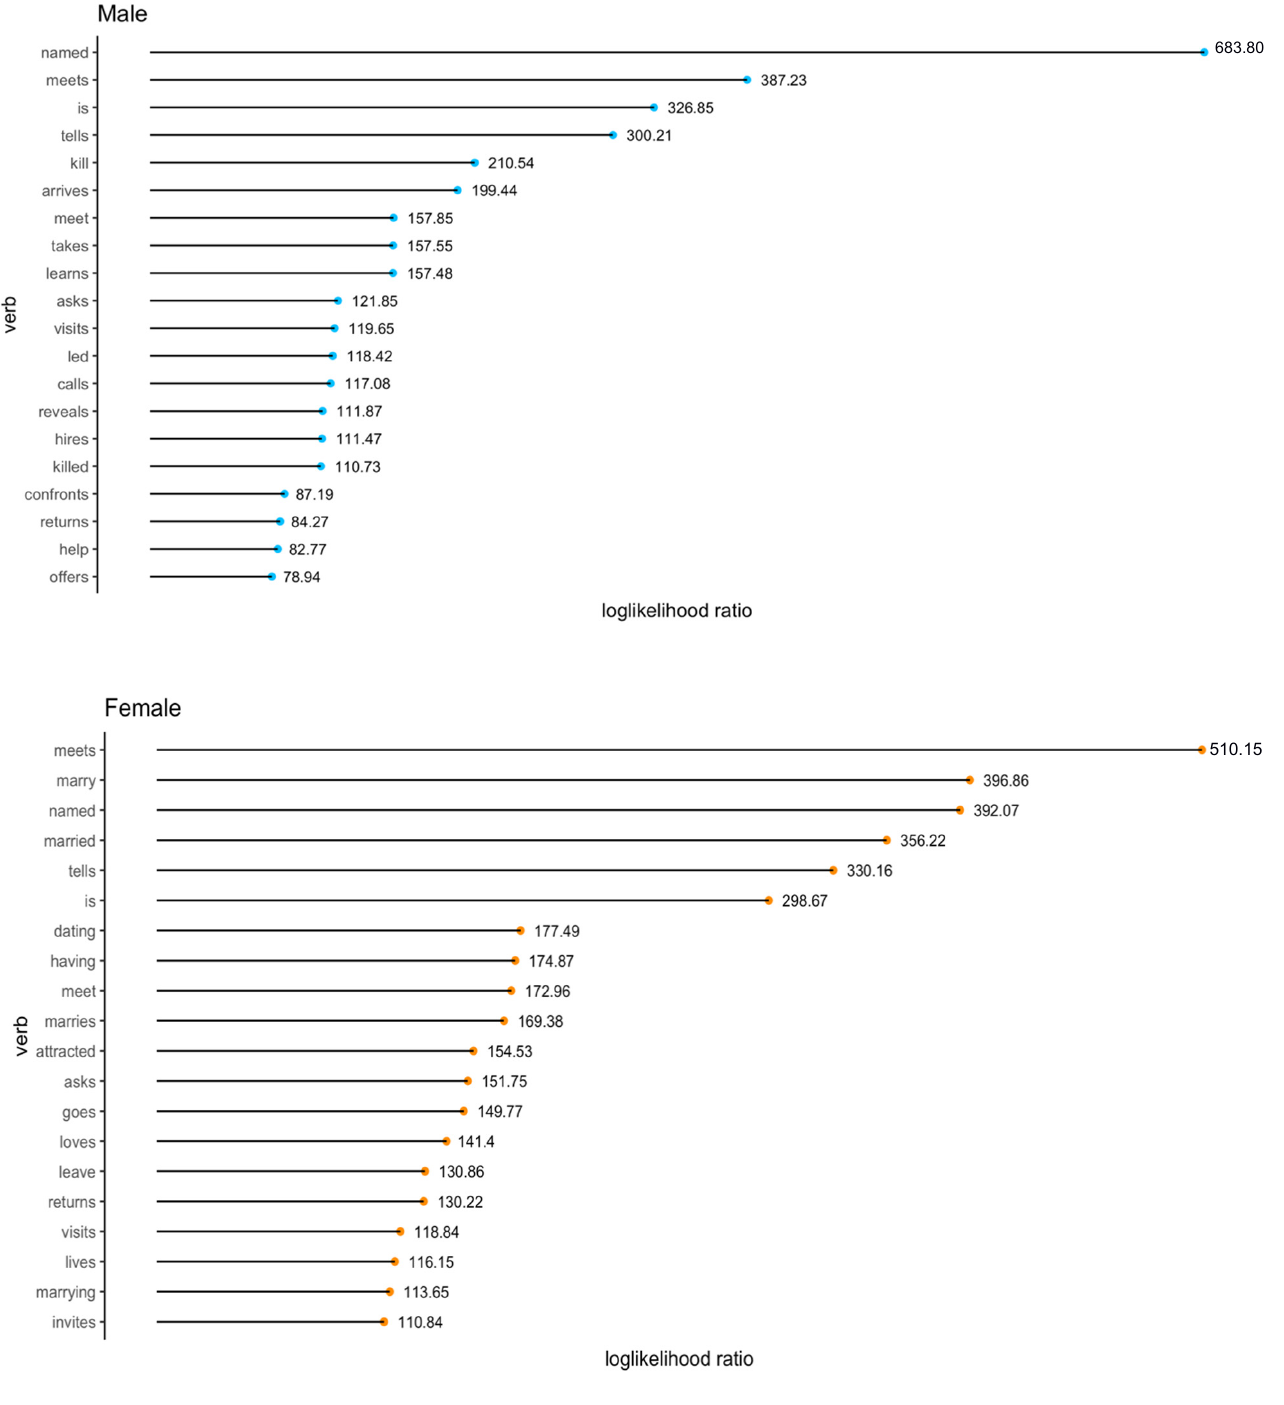
Figure 10. Needle plot representing edge weights of the twenty most significant primary verb associations of male characters ( top ) and female characters ( bottom ).